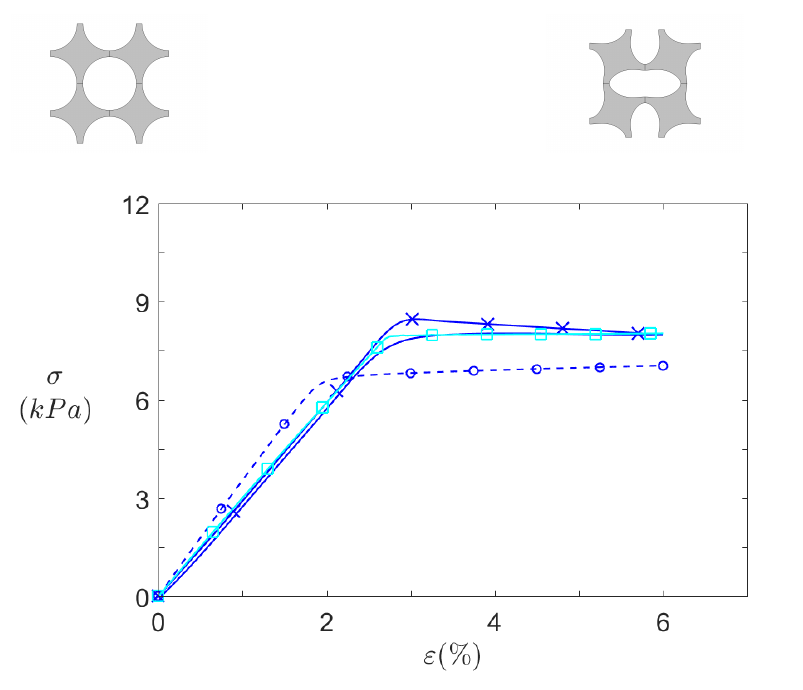
Figure 12. Static behaviour of S 0 pattern under axial compression. Effective stresses σ against com- pression axis ( Y ) for infinite plates computations, finite 8 × 7 structures computations, and experimental 8 × 7 samples.